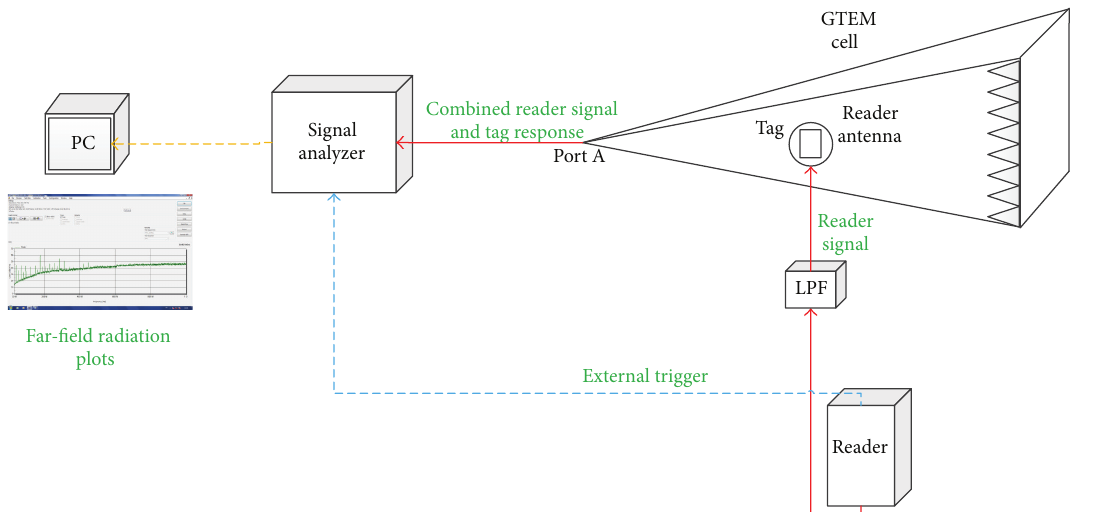
Figure 9: GTEM cell and EUT.